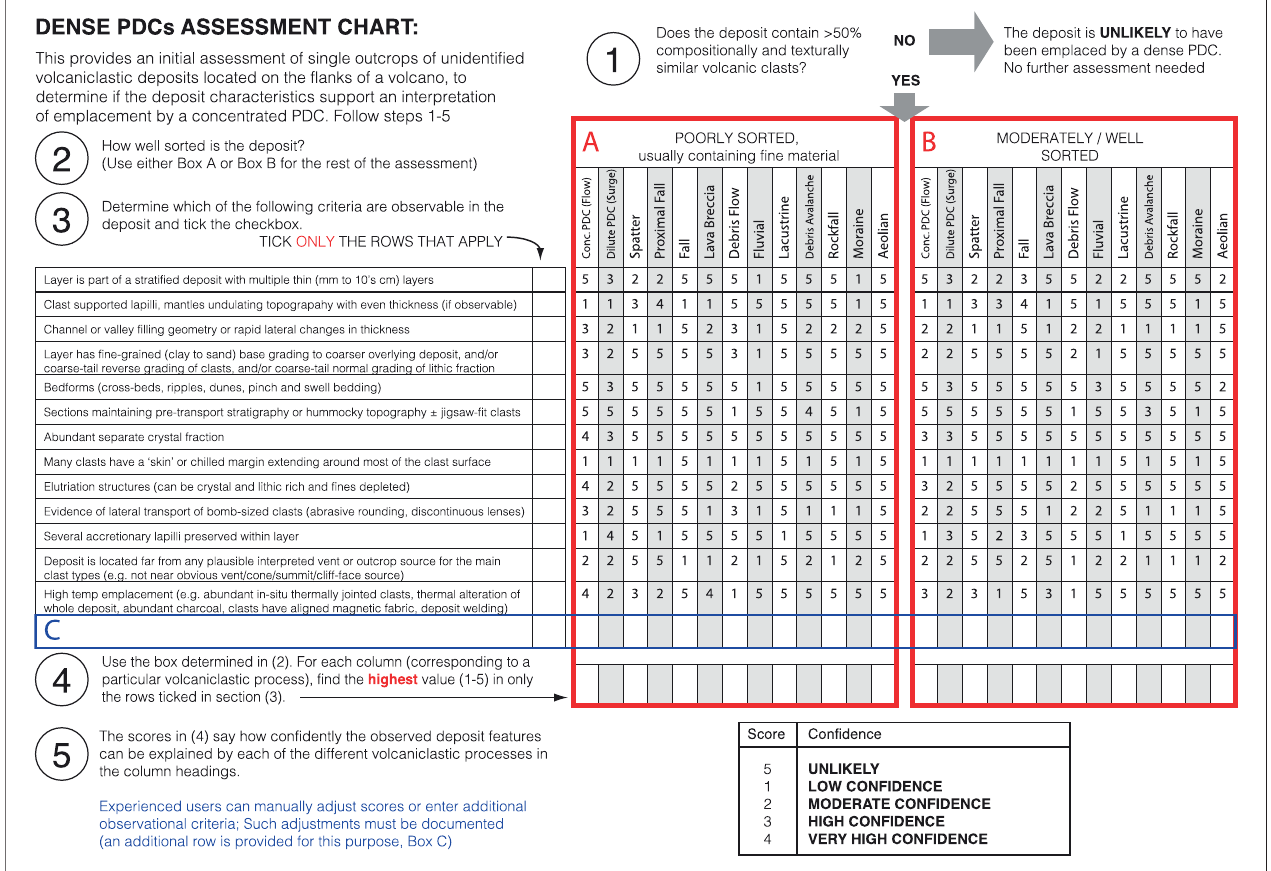
FIGURE 3 | The new con fi dence-based system for assessing candidate pyroclastic fl ow